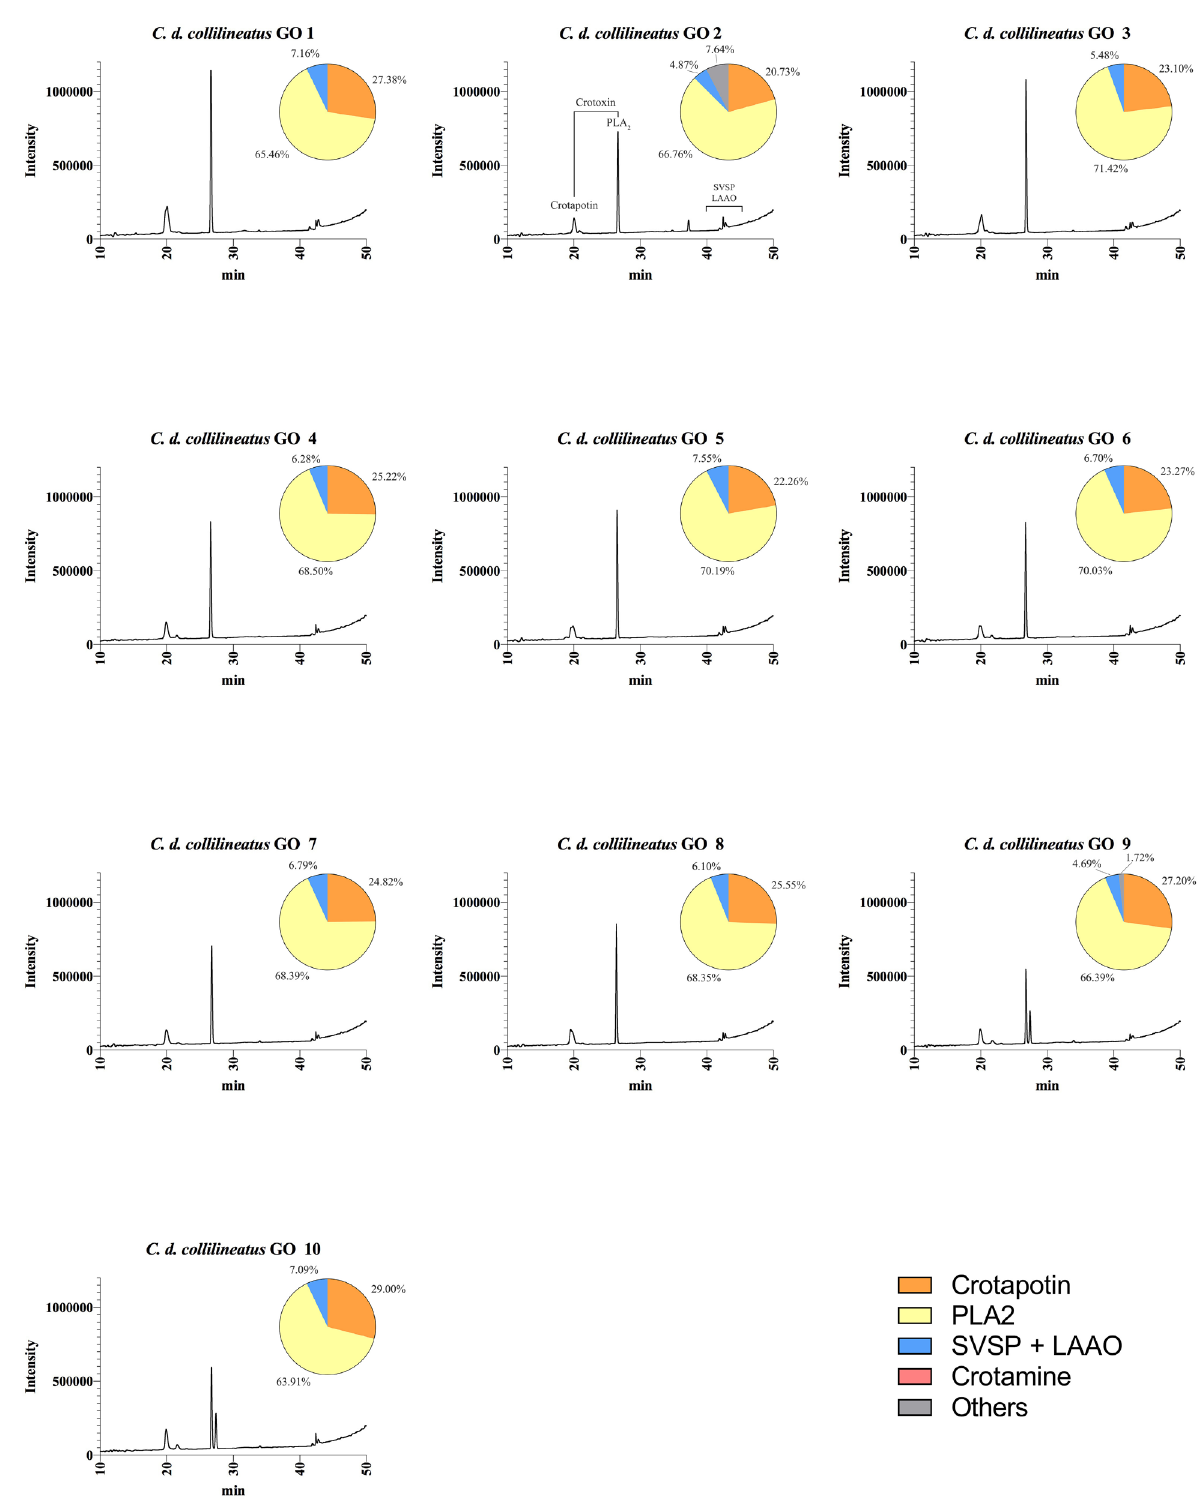
Figure 4. Elution profiles of individual C. d. collilineatus venom from Goiás state by RP-HPLC. Samples of 25 μg of lyophilized venom were dissolved in 0.1% trifluoroacetic acid (TFA) and 5% acetonitrile (solution A) and subjected to RP-HPLC on a C18 column. Elution was performed at 1.0 mL/min by applying a gradient toward 0.1% TFA and 95% acetonitrile (solution B), as described in the experimental section. The main chromatographic peaks of one representative were assigned to its major components. This representative was selected based on the presence/absence and intensity of particular chromatographic peaks. LAAO: L-amino acid oxidases; SVSP: snake venom serine proteases, PLA : phospholipases A 2 2